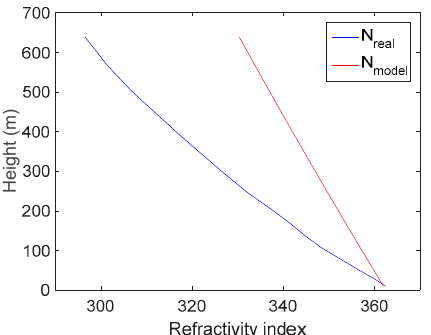
Figure 11. Duct anomaly observed at 12:00 for location (50.7° N, 75.6° E) on 11 June 2016.